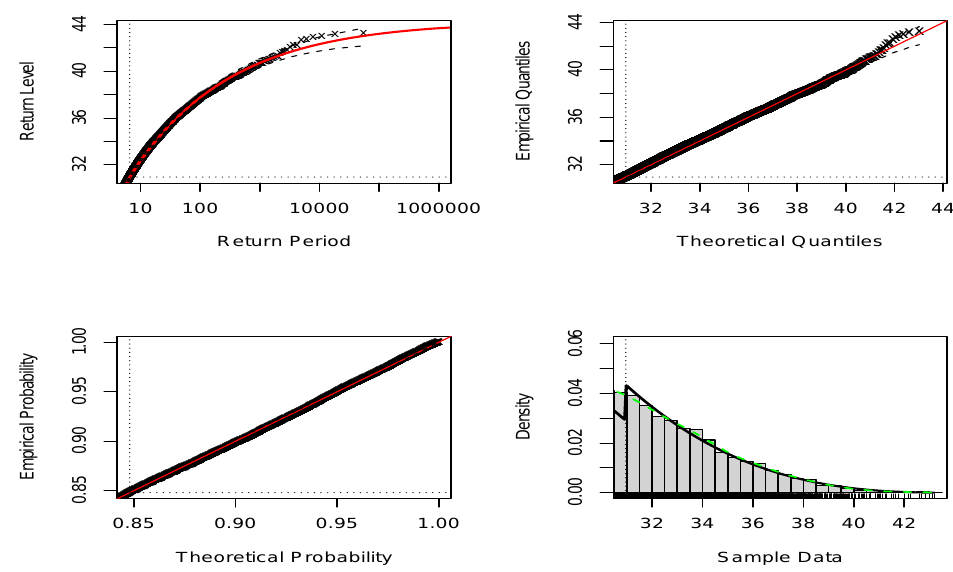
Figure A3. Diagnostic plots for fitted Parameterised tail fraction of